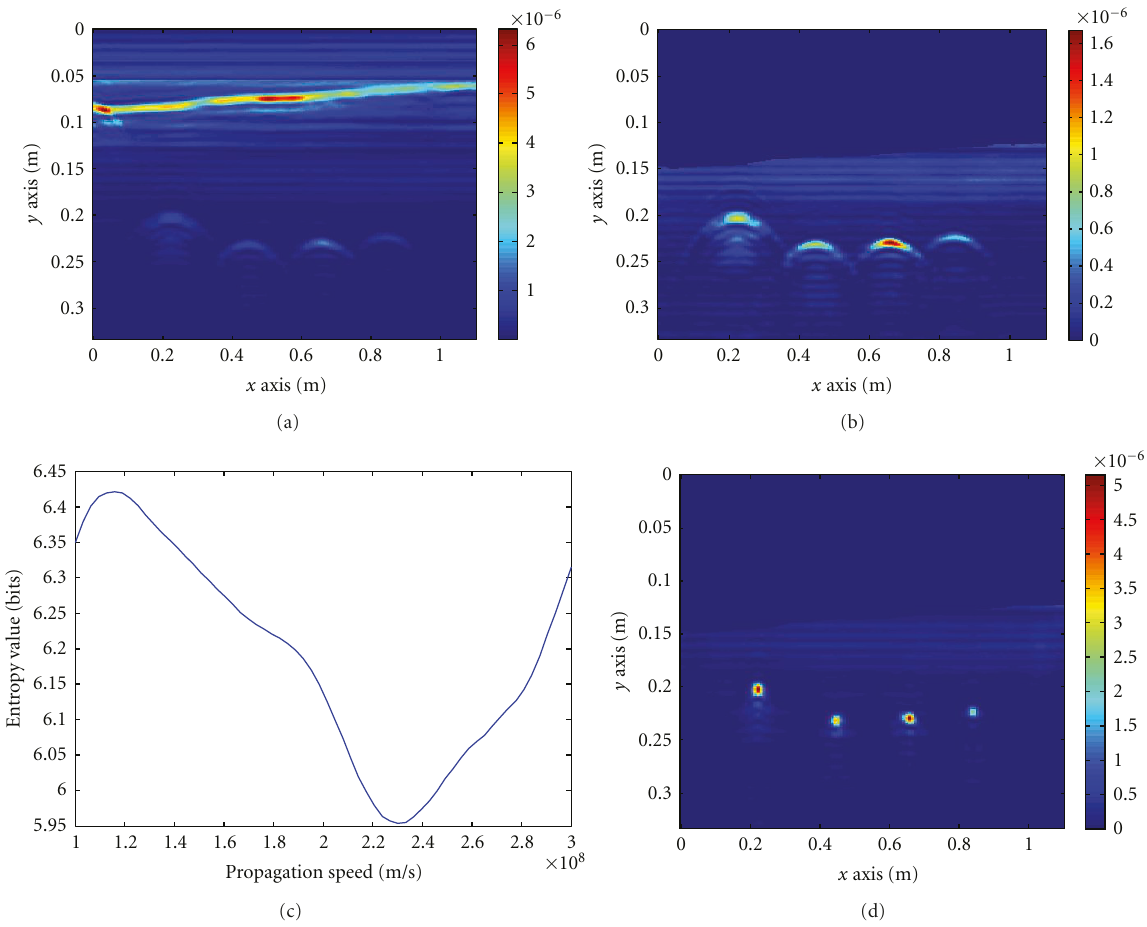
Figure 13: (a) Fourth experimental data set. (b) Denoised data set. (c) Entropy values for the interval [1 × 10 8 m/s, 3 × 10 8 m/s]. (d) Dataset reconstructed using v ∗